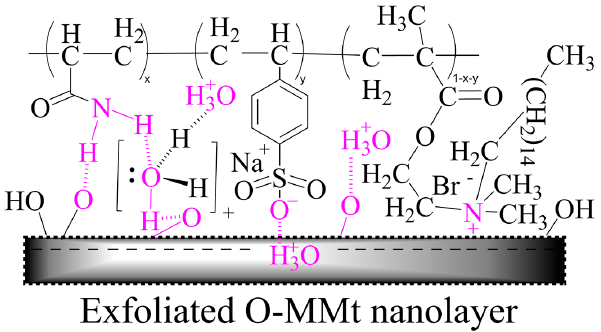
Figure 17. Proposed mechanism for exfoliated O-MMt nanolayer adsorption.